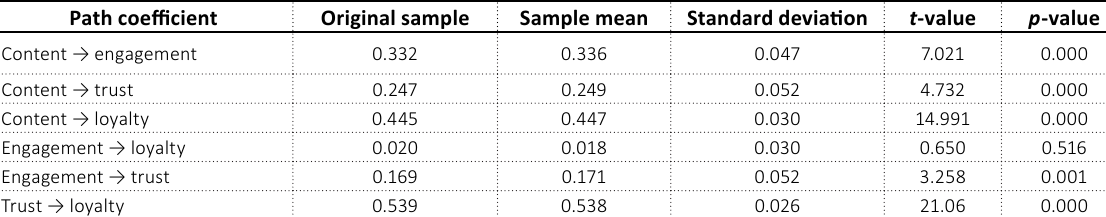
Table 4. Path coefficient-bootstrapping